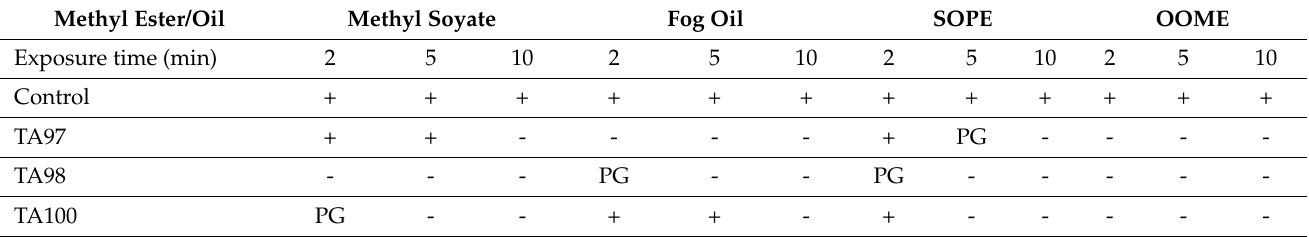
Table 1. Relative antibacterial activities of vegetable oil esters and fog oil aerosols. Methyl Ester/Oil Methyl Soyate